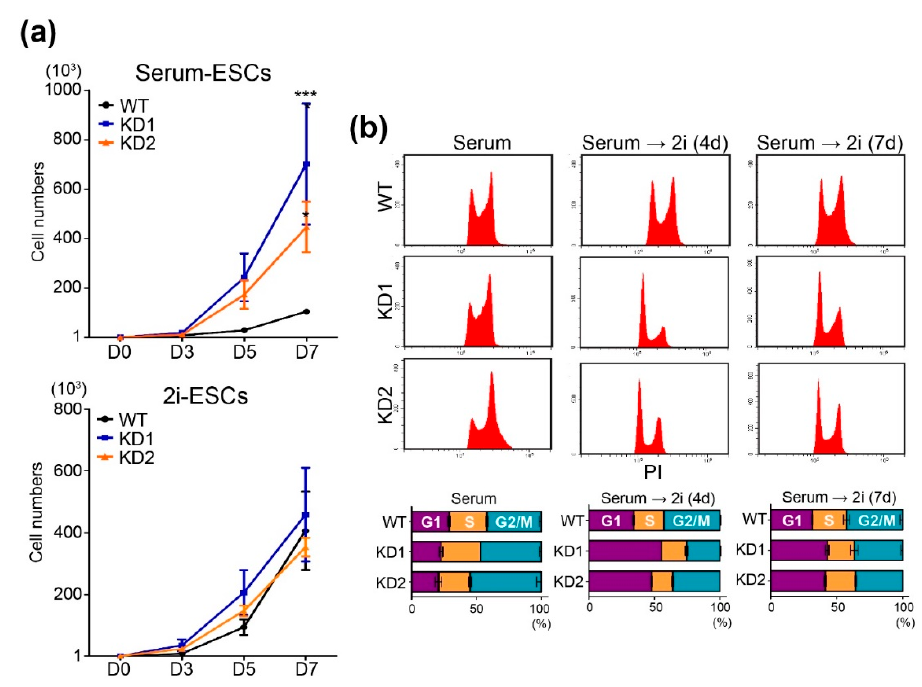
Figure 2. Chd9 depletion changes cell cycle distributions in the serum-ESCs. ( a ) Cell numbers of the Wild type (WT) and KD ESCs were measured at 3, 5, and 7 d after seeding 1000 ESCs in either normal serum (serum-ESC) or 2i-LIF (2i-ESC) (n = 3). ( b ) Histogram graph and percentages of G1, S, and G2 / M phases in the WT and KD ESCs analyzed by flow cytometry (n =